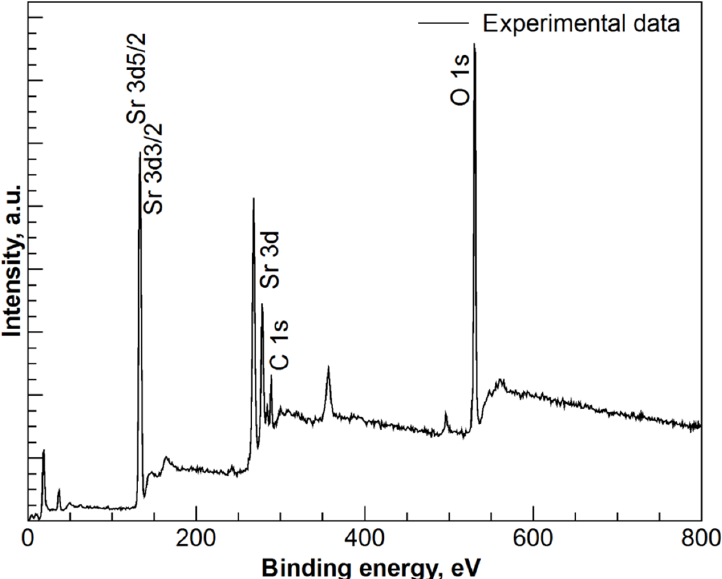
Figure 2. X ‐ ray Photoelectron Spectroscopy (XPS) spectrum for SrCO 3 ‐ Sr(HO) 2 nanocomposite.